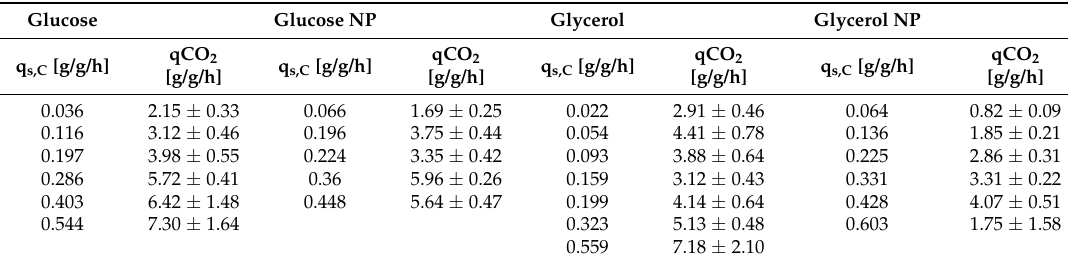
Table 4. Specific substrate uptake rate vs. specific carbon evolution rate. Product producing strains have in general increased respiratory activity. NP strains show reduced respiratory activity. Standard deviation of qCO 2 increases at higher feeding